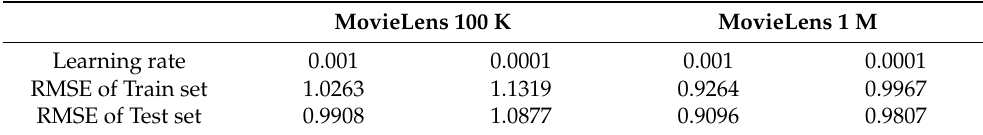
Table 2. RMSE scores of the multimodal movie recommendation algorithm based on deep learning.